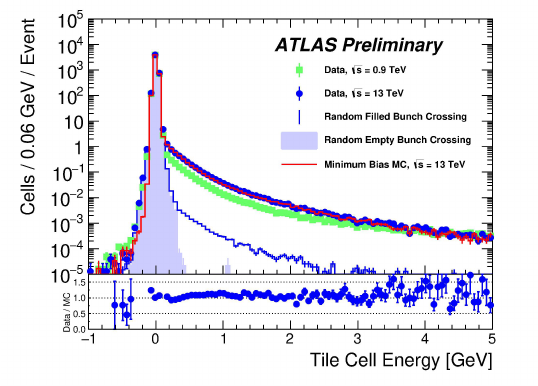
Figure 4: Distributions of the energy deposited in the TileCal cells from collision data (cid:112) s = 13 and 0.9TeV superimposed with Pythia minimum bias MC and randomly at triggered events from filled and empty bunch crossings [ 6 ]